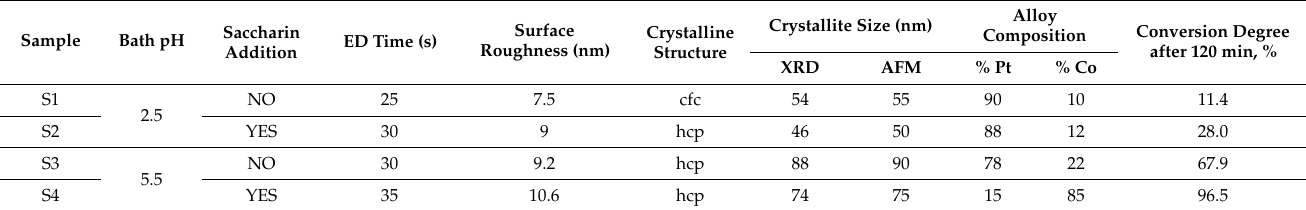
Table 1. Physical and chemical parameters of the CoPt